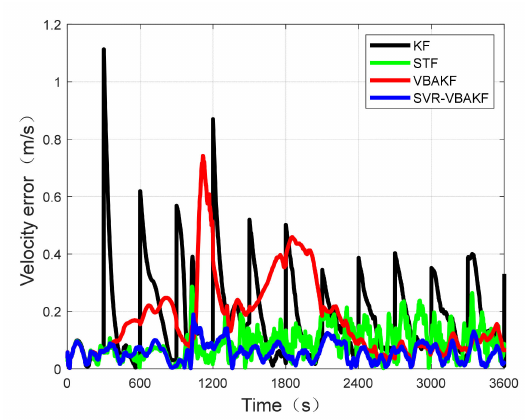
Figure 6. Comparison of position errors.